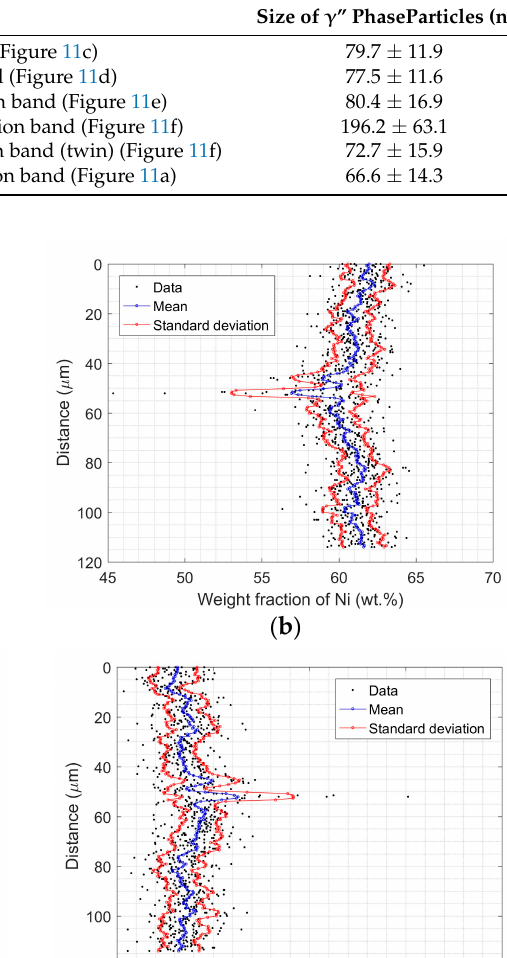
Table 4. The average size and standard deviation of γ ” phase particles in different areas on Figure 11 (sample hot rolled at 1050 ◦ C with the deformation level of 23.5% and aged at 750 ◦ C for 25 h). Location Size of γ ” PhaseParticles (nm) Deformed grain in the segregation band (Figure 11c) 79.7 ± 11.9 Recrystallized grain in the segregation band (Figure 11d) 77.5 ± 11.6 Deformed grain, the inner edge of the segregation band (Figure 11e) 80.4 ± 16.9 Recrystallized grain, the inner edge of the segregation band (Figure 11f) 196.2 ± 63.1 Recrystallized grain in the inner edge of the segregation band (twin) (Figure 11f) 72.7 ± 15.9 Deformed grain in the outer edge of the segregation band (Figure 11a)